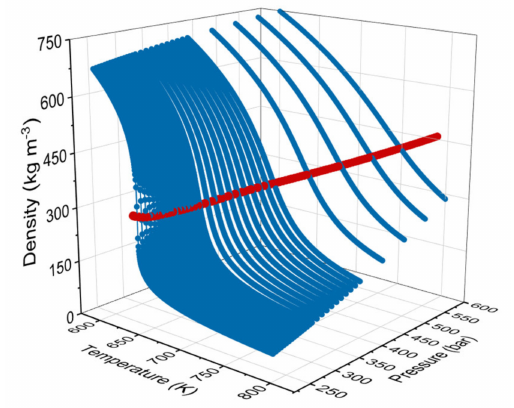
Figure 1. Water density variation with temperature along isobars in the PB region; the red line corresponds to the density values at the PB-Widom line calculated based on Banuti’s theory [45]; Water’s density values on the blue curves have been obtained from publicly available NIST database at https://webbook.nist.gov/chemistry/fluid (last accessed on 28 October